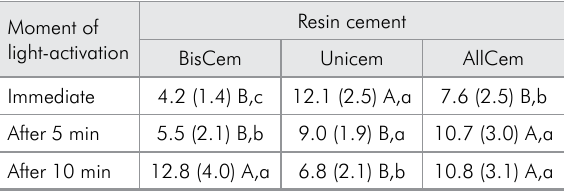
table 2. Means (standard deviations) for push-out bond strength, MPa (n =